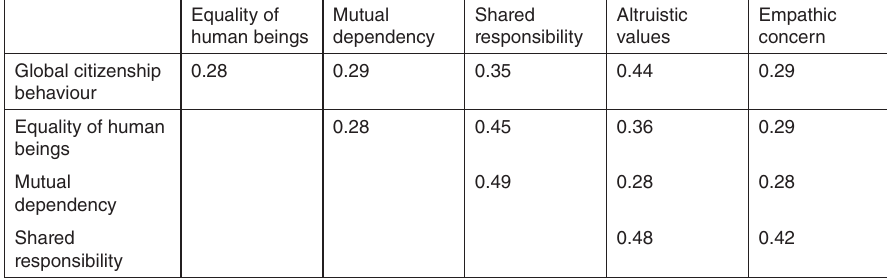
Table 5: Pearson’s correlation coefficient between the GCI, altruistic values, and empathic